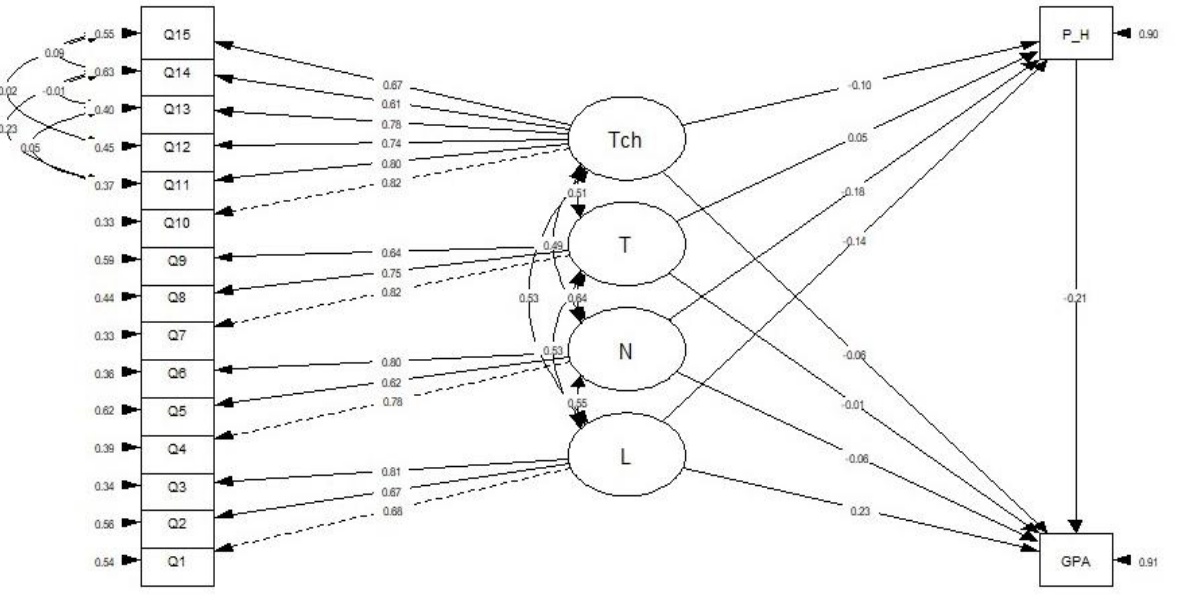
Figure 2. Final SEM Model (model 1). Tch = Technology, T = Temperature, N = Noise, L = Lighting, P_H = Psychological health, GPA = Grade Point Average (academic performance).